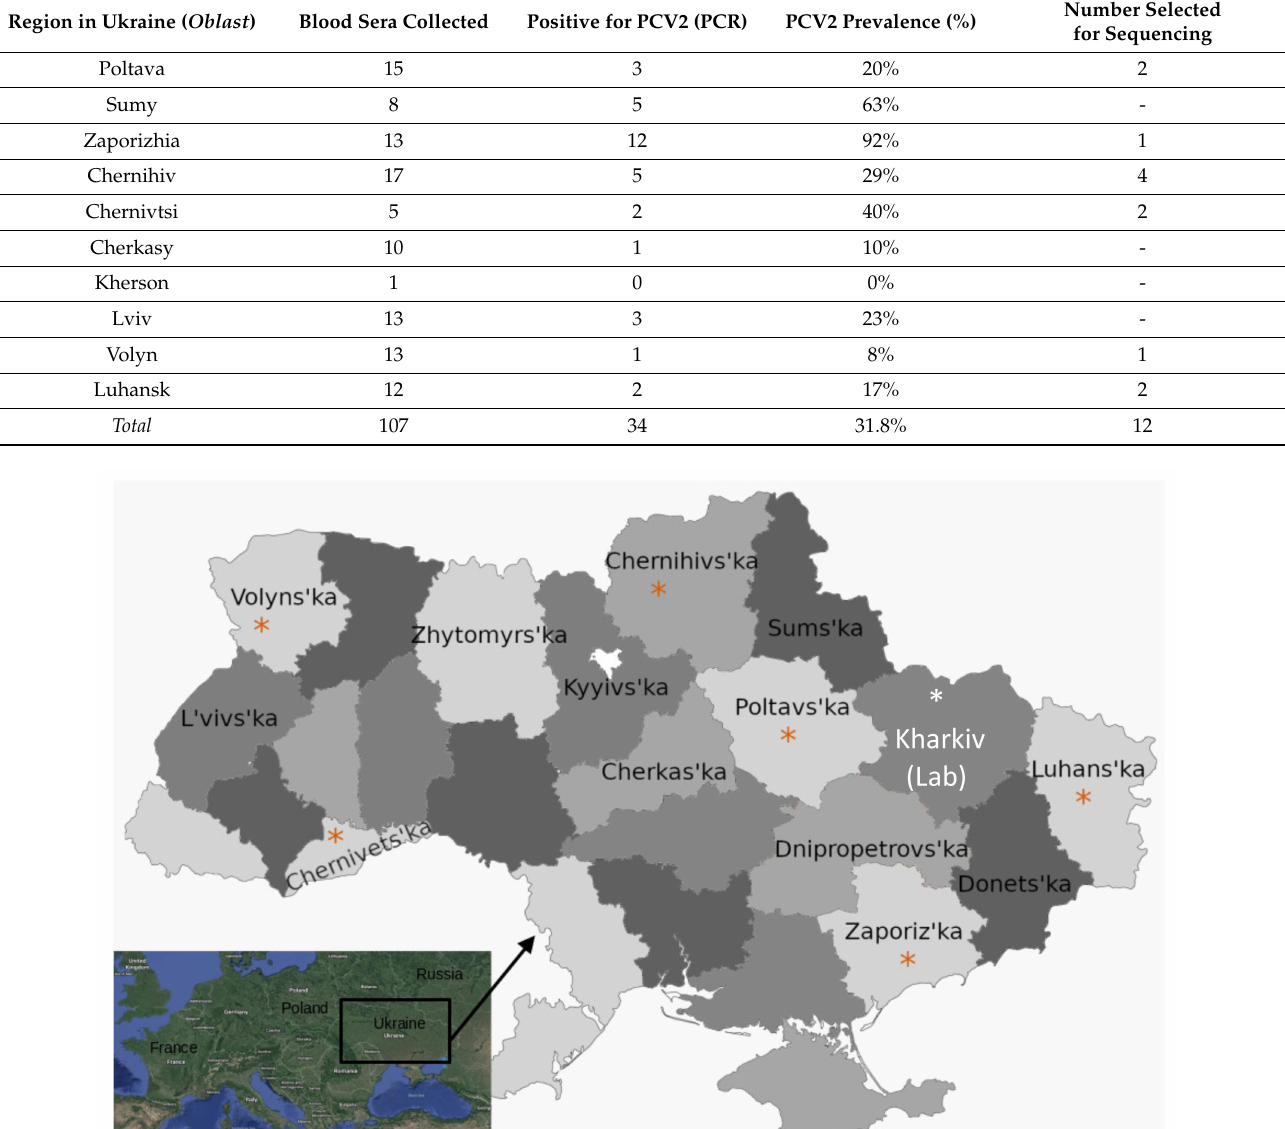
Table 1. Porcine circovirus 2 detection in hunted wild boar in Ukraine by PCR (2012).